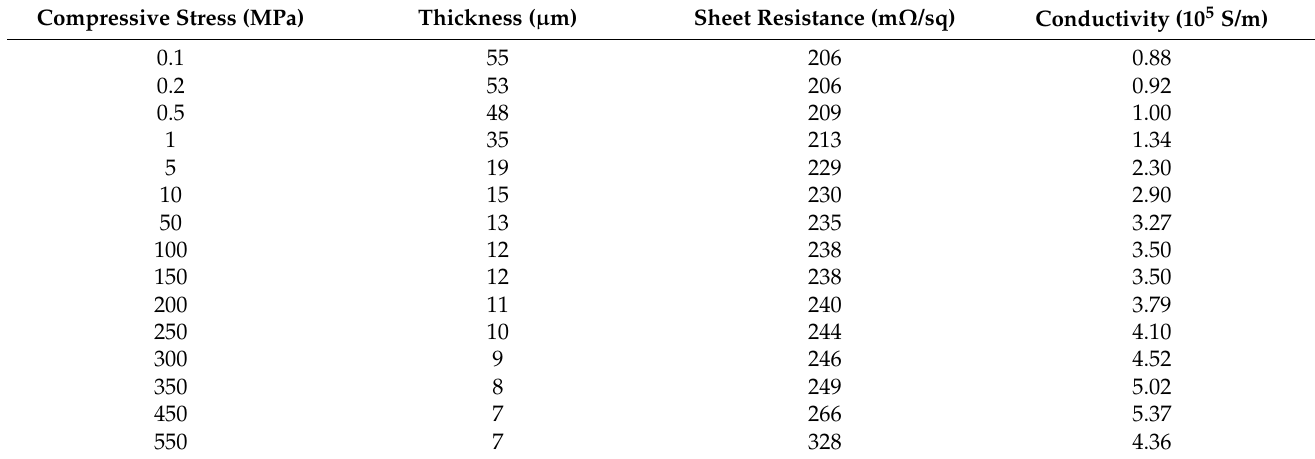
Figure 3. Measurement results of c-GAFs. ( a ) Electrical conductivity and thickness for c-GAFs. ( b ) Top-view and cross-sectional (inset) optical images of various c-GAFs. ( c ) Load-strain curve for c-GAFs. Table 1. Summary of conductivity of c-GAF obtained with different